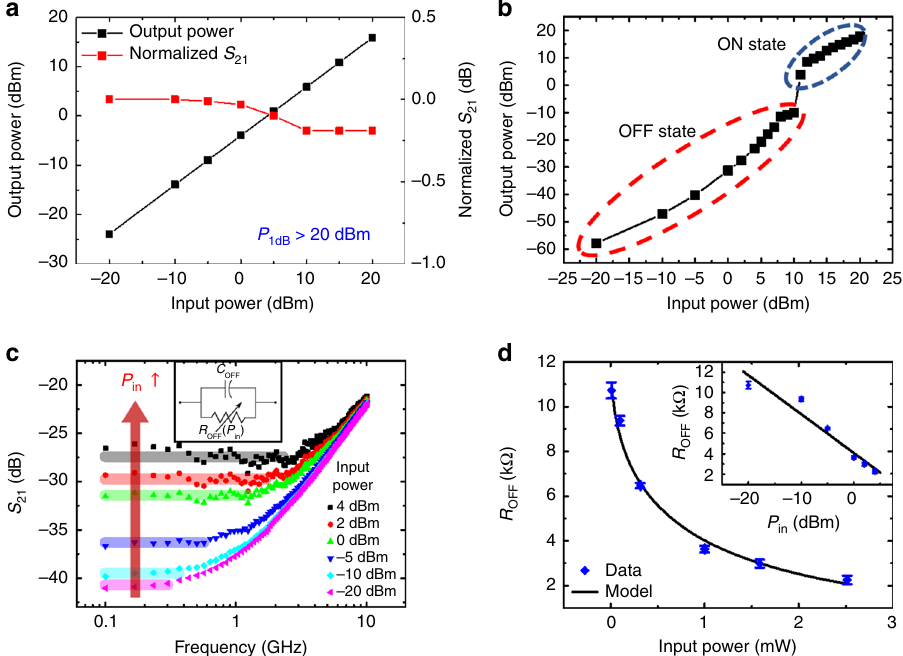
Fig. 5 Signal power handling of MoS 2 RF switches. a Representative ON-state P 1dB and normalized insertion loss measured at 1 GHz in monolayer MoS 2 RF switch with lateral area of 0.25 × 0.5 μ m 2 . b OFF-state power handling measured at 1 GHz in monolayer MoS 2 RF switch with lateral area of 0.5 × 0.5 μ m 2 . c Transmission spectrum of an OFF-state monolayer MoS 2 RF switch at different RF input powers. The inset shows an equivalent lumped element circuit model including an OFF-state capacitance (~13 fF) in parallel with an OFF-state variable resistance. d OFF-state resistance has an exponentially decreasing dependence on RF input power, which can be modeled as a diode-like voltage-dependent resistance (model line). The error bar indicates the standard